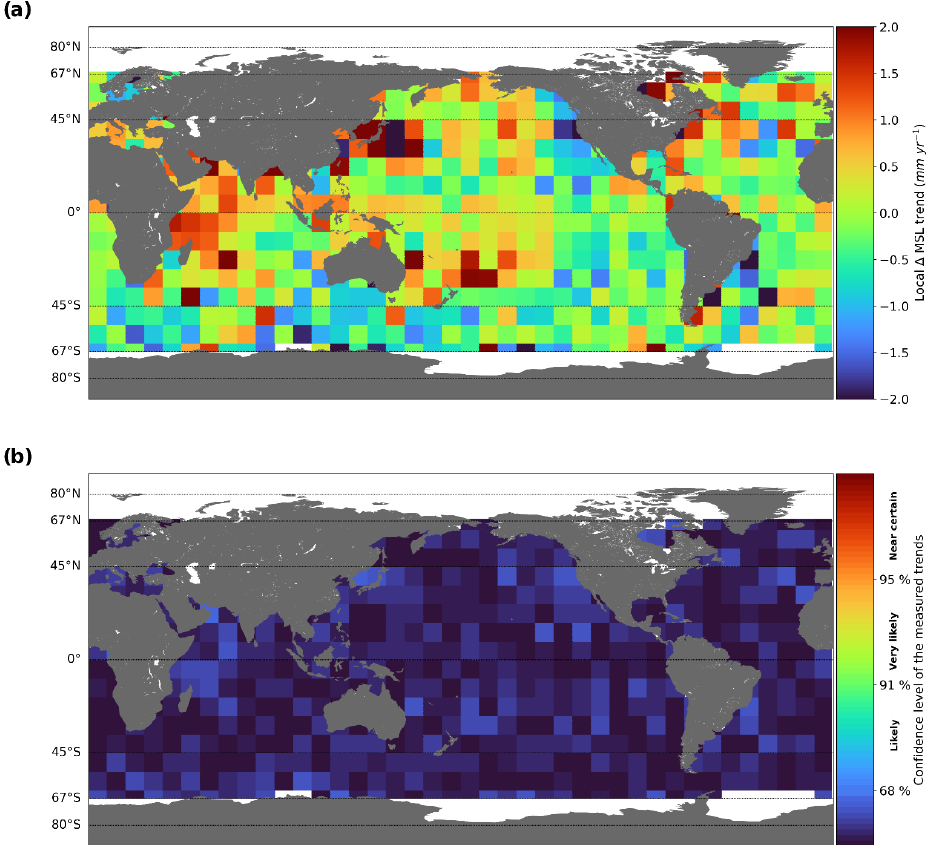
Figure 5. (a) Regional MSL trends between S3A and Jason-3 after removing the global mean trend (i.e., 1.13mmyr − 1 in 9 ◦ × 9 ◦ resolution). (b) Confidence level of the measured regional MSL trends computed from local MSL trends divided by regional uncertainties between S3A and Jason-3 in 9 ◦ × 9 ◦ resolution.